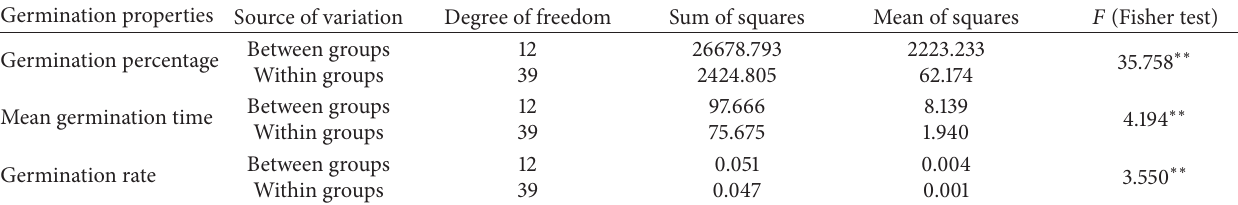
Table 1: Analysis of variance for treatments on germination properties of C. persica . Germination properties Source of